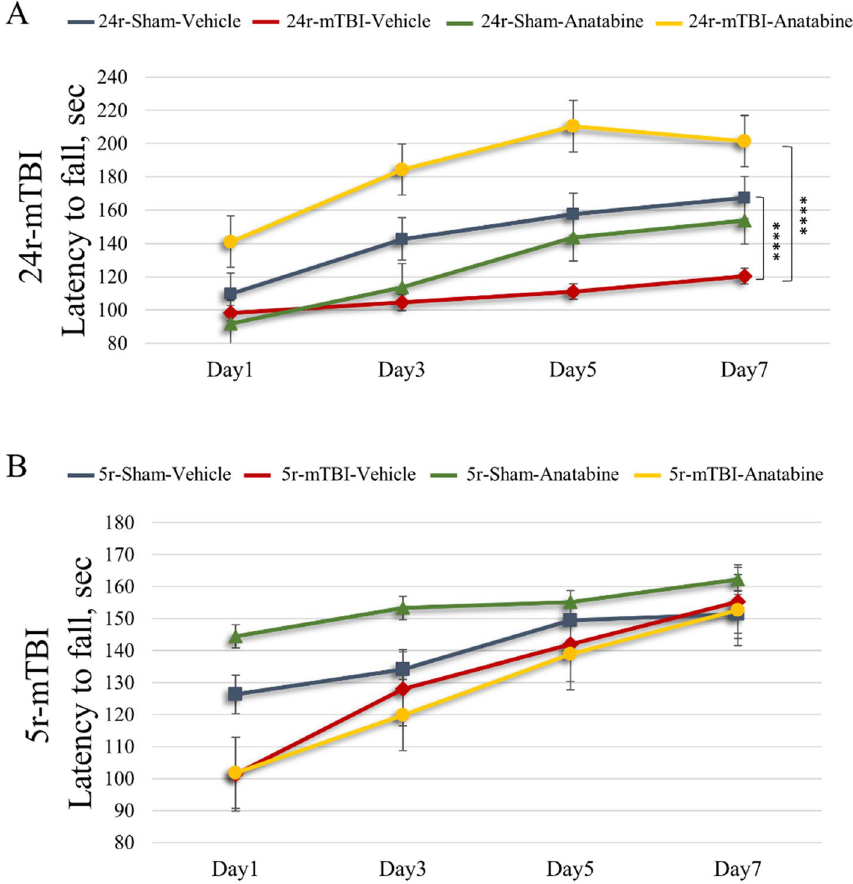
Figure 3. Evaluation of the effect of TBI and of anatabine on motor performance. ( A ) 24r-mTBI-vehicle mice exhibited a decrease in latency over the 7-day period compared to 24r-Sham-Vehicle controls (p < 0.0001). Treatment with anatabine in 24r-mTBI mice increased latency from Day1 to Day7 (p < 0.0001). ( B ) 5r-mTBI- Vehicle mice exhibited a decreased latency compared to 5r-Sham-Vehicle on Day1 and Day 3 but not on Day5 and Day7. Mice of 5r-mTBI-Anatabine group had no difference in latency compared to 5r-mTBI-Vehicle mice (p > 0.05). All data were normalized to baseline and analyzed using